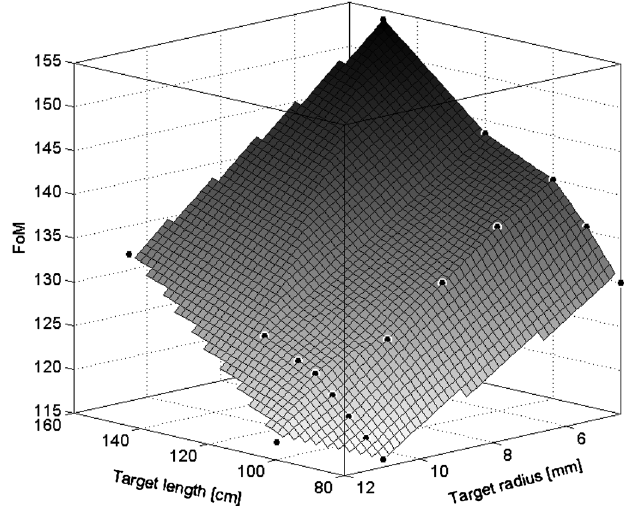
FIG. 6. End deflection of a 1 m long 21 mm diameter cantilevered beryllium cylinder with 2.3 MW beam, applied with an offset of 2 σ = 7 mm beam offset.